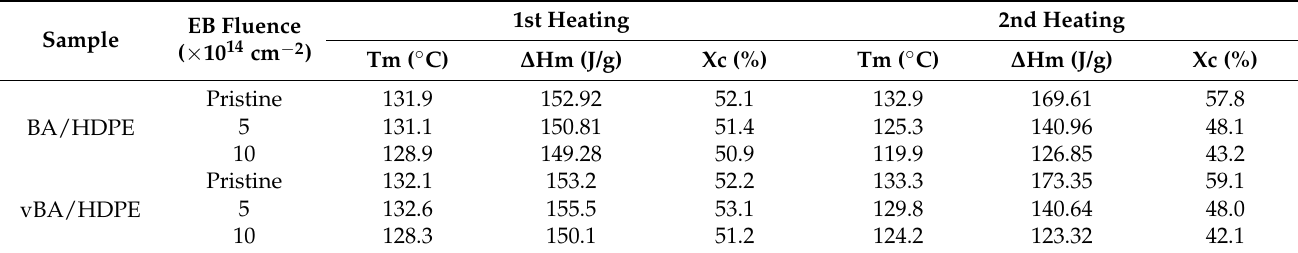
Figure 7. Differential scanning calorimeter (DSC) thermograms of pristine and irradiated BA/HDPE and vBA/HDPE at first heating cycle ( a ) and second heating cycle ( b ). Table 1. The melting characteristics of pristine and irradiated BA/HDPE and vBA/HDPE.